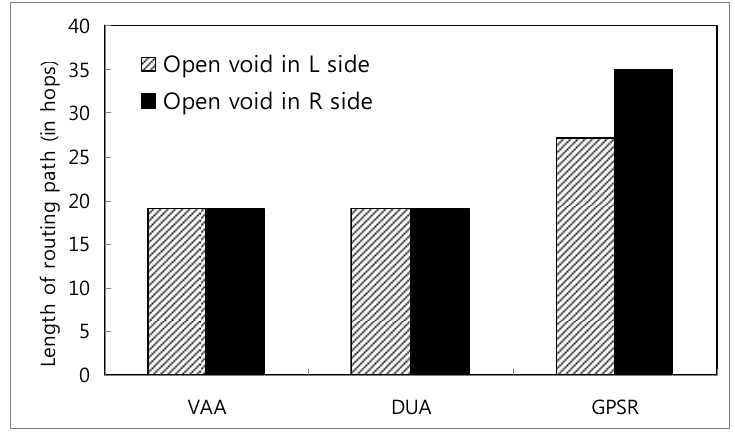
Figure 17. Length of routing path when there is one open void.